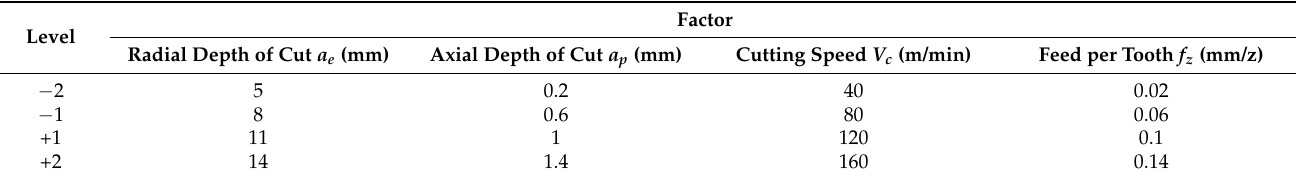
Table 1. Factors and levels for orthogonal experimental design.